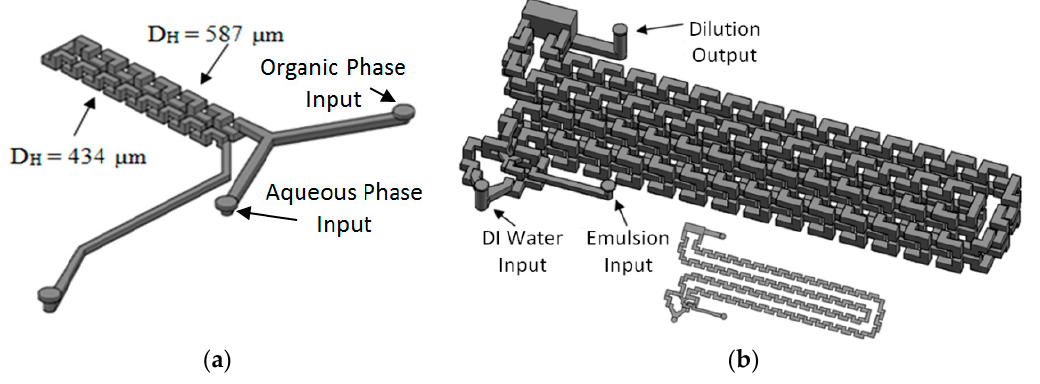
Figure 20. Microfluidic devices used for: ( a ) Emulsification module; ( b ) Diffusion module.